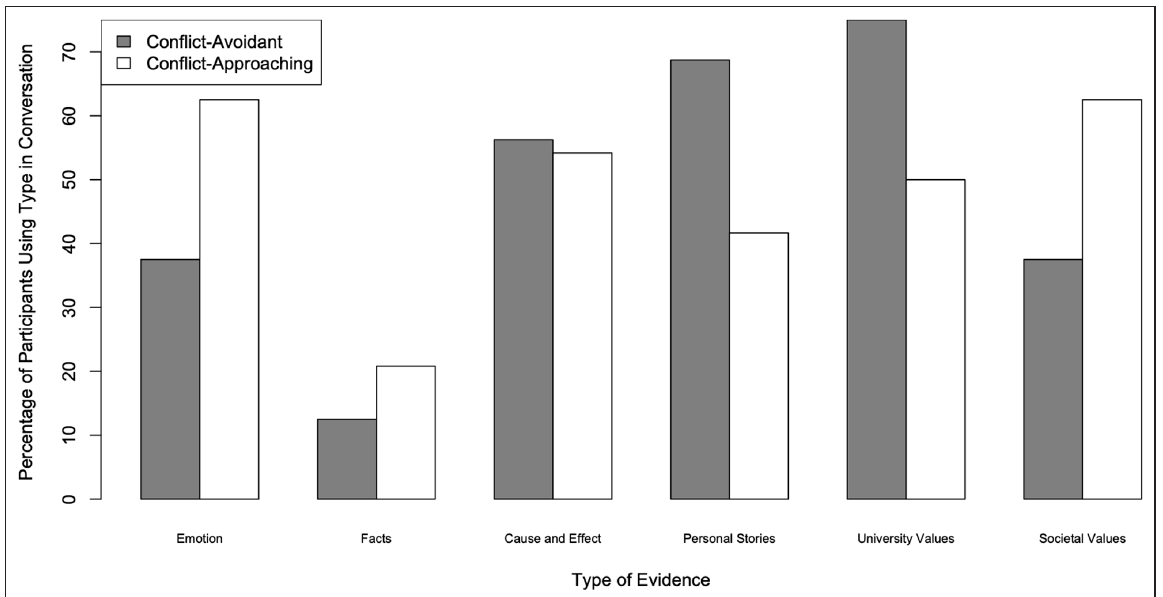
Figure 2: Frequency of Certain Types of Evidence Use Across Conflict